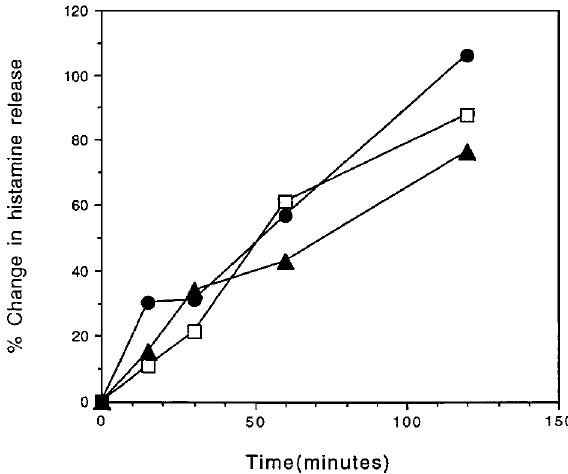
FIG. 4. Anti-IgE induced histamine release in nasal mucosa ( – s – ) compared with spontaneous release ( – j – ). This figure demonstrates the effect of IgE on histamine release in nasal